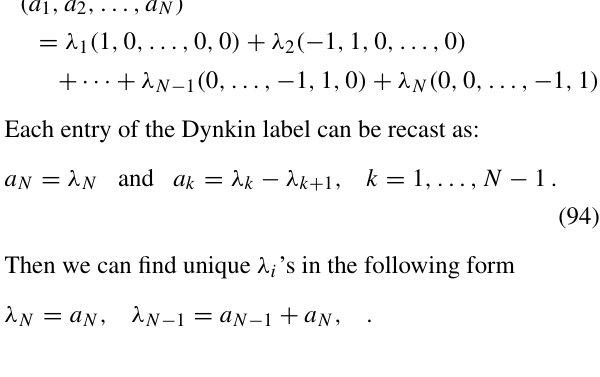
– The Fundamental Representation: 4 ≡ ( 1 , 0